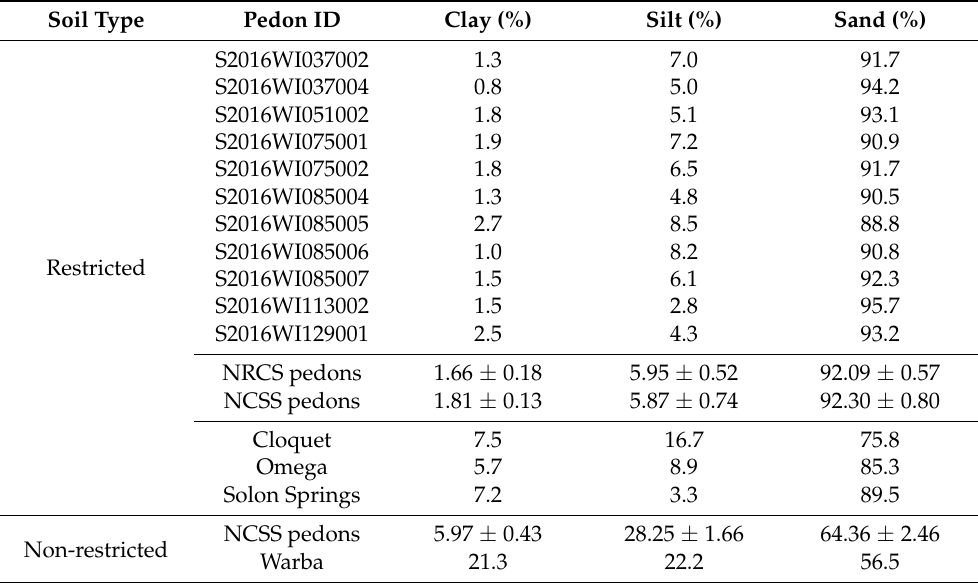
Table A1. Soil texture within the top 150 cm comparing observed soil pedons to outwash soils used to calculate weathering rates. The named soils which show larger clay and silt percentages [24].